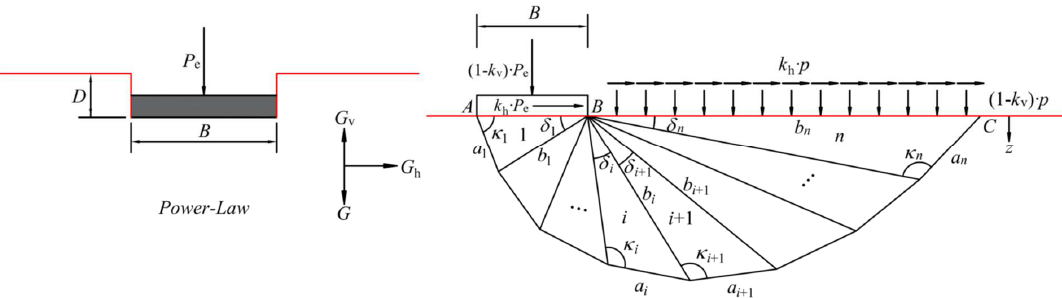
Figure 2. Sketch map of shallow foundation failure mechanism under the seismic condition.